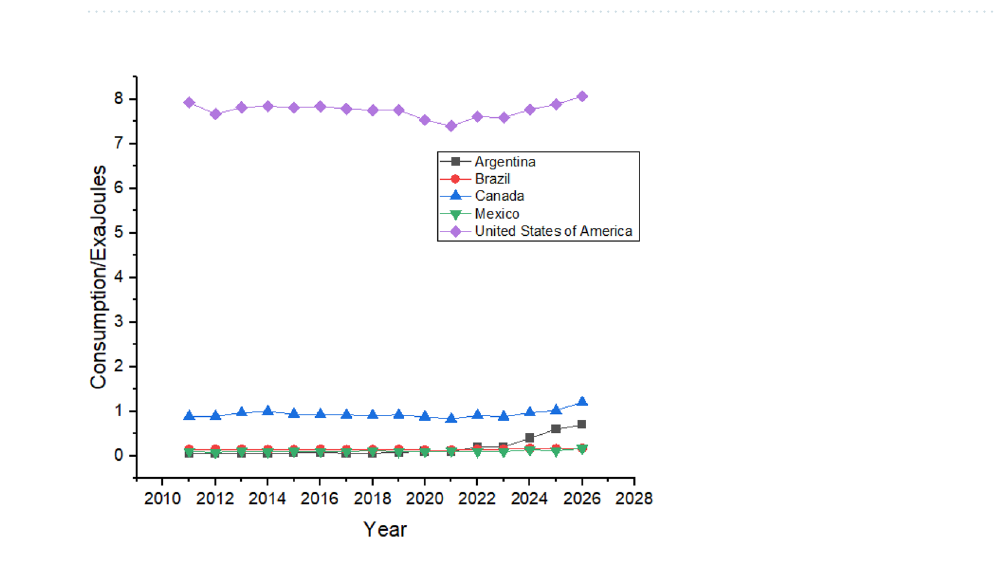
Figure 8. Oil consumption in Asian Region.